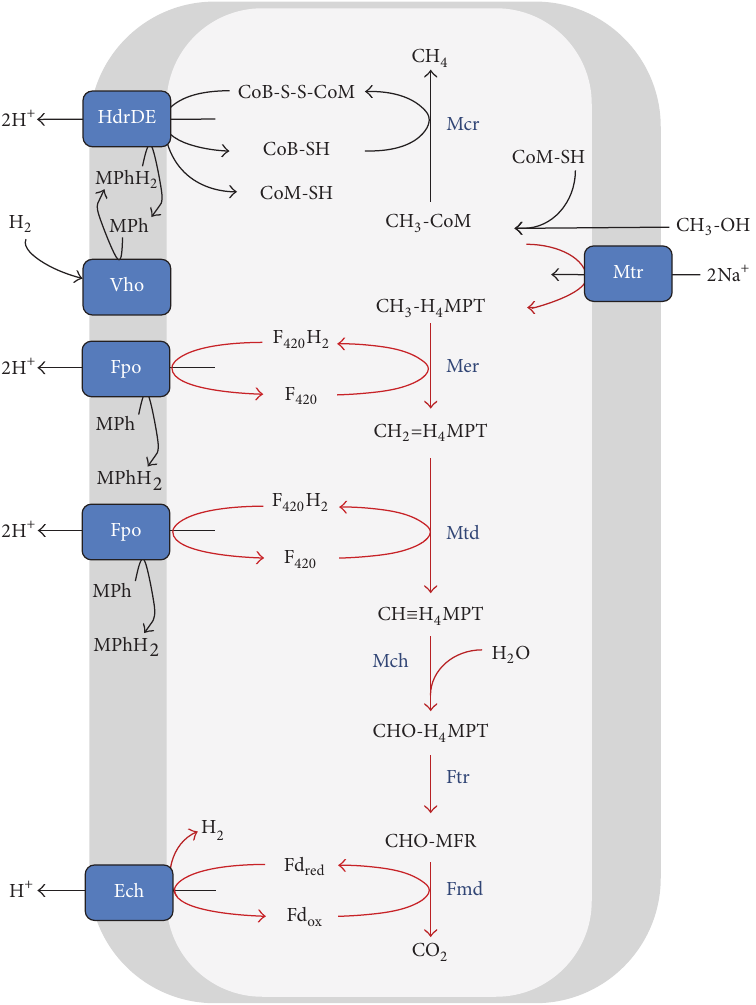
Figure 3: Methylotrophic methanogenesis in cytochrome containing Methanosarcina barkeri . Black lines represent presence of conversions and red lines indicate reversal of the hydrogenotrophic methanogenic pathway. See Table 3 for